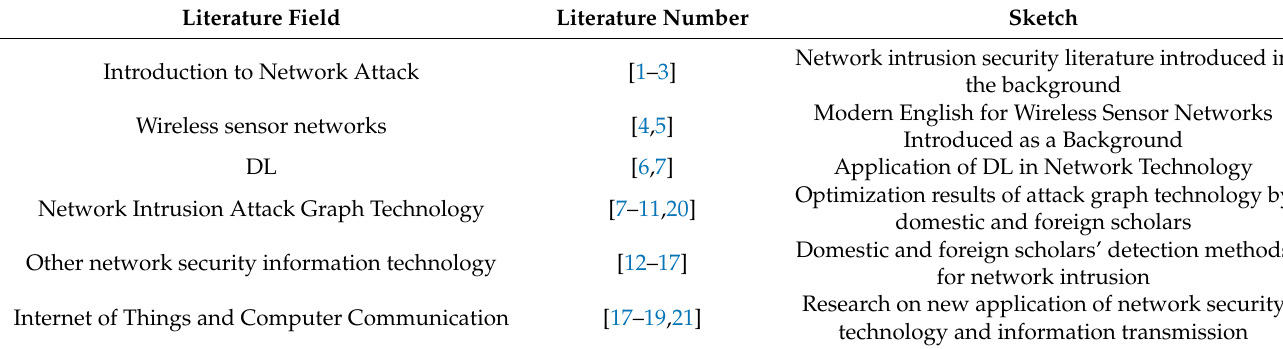
Table 1. Distribution of Cited References.